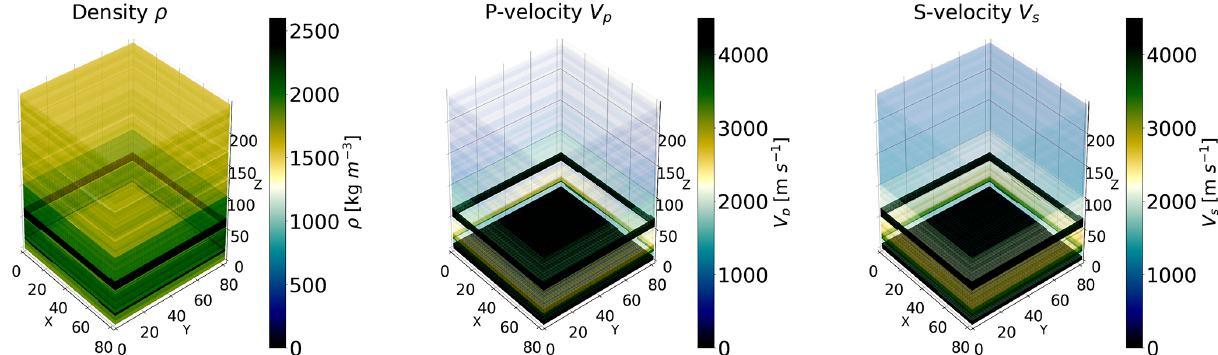
Figure 7. Density, P-wave velocity, and S-wave velocity models of the simulated domain used in this work. The models are specified as 3D grids of voxels. They show a layered structure with strong variability along the vertical axis. However, a smaller degree of variability is also present across the horizontal plane; hence, the models are effectively 3D models that cannot be accurately simulated as a 1D layered